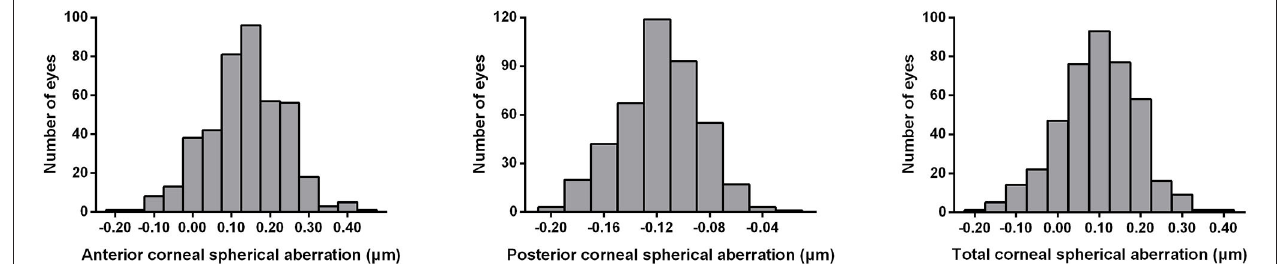
FIGURE 1 | Distribution of anterior, posterior, and total spherical aberrations of the cornea measured by the Pentacam system in 420 eyes of patients with bilateral ectopia lentis. ASA, anterior spherical aberration; PSA, posterior spherical aberration; TSA, total spherical aberration.